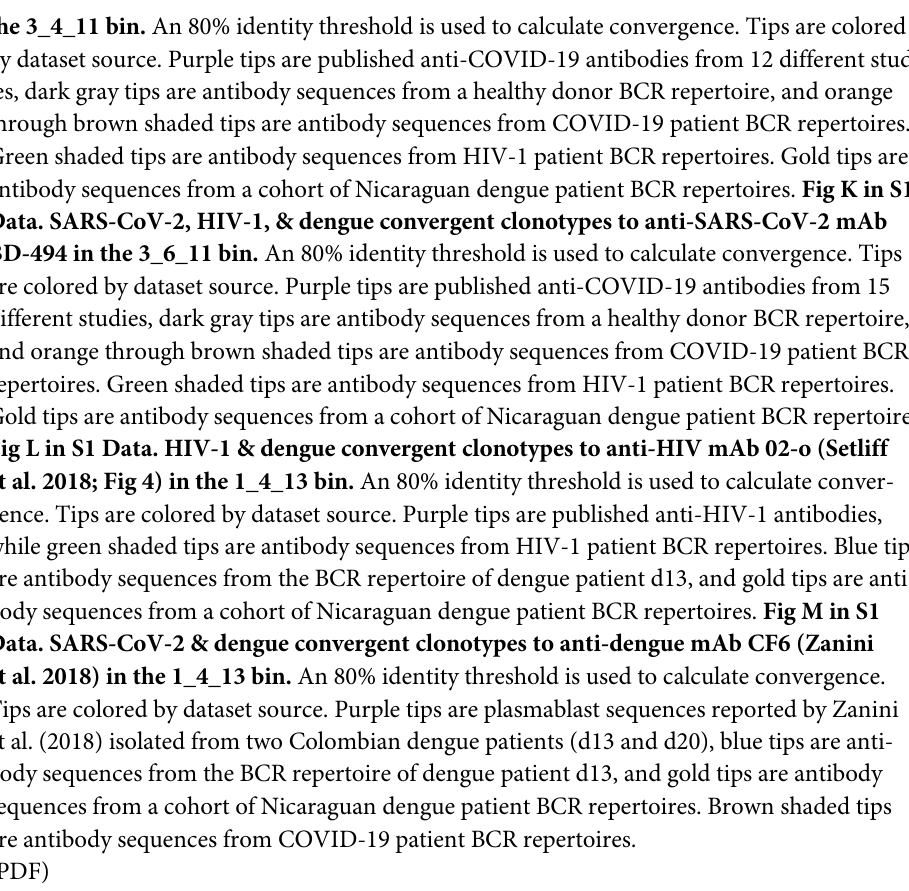
the 3_4_11 bin. An 80% identity threshold is used to calculate convergence. Tips are colored by dataset source. Purple tips are published anti-COVID-19 antibodies from 12 different stud- ies, dark gray tips are antibody sequences from a healthy donor BCR repertoire, and orange through brown shaded tips are antibody sequences from COVID-19 patient BCR repertoires. Green shaded tips are antibody sequences from HIV-1 patient BCR repertoires. Gold tips are antibody sequences from a cohort of Nicaraguan dengue patient BCR repertoires. Fig K in S1 Data. SARS-CoV-2, HIV-1, & dengue convergent clonotypes to anti-SARS-CoV-2 mAb BD-494 in the 3_6_11 bin. An 80% identity threshold is used to calculate convergence. Tips are colored by dataset source. Purple tips are published anti-COVID-19 antibodies from 15 different studies, dark gray tips are antibody sequences from a healthy donor BCR repertoire, and orange through brown shaded tips are antibody sequences from COVID-19 patient BCR repertoires. Green shaded tips are antibody sequences from HIV-1 patient BCR repertoires. Gold tips are antibody sequences from a cohort of Nicaraguan dengue patient BCR repertoires. Fig L in S1 Data. HIV-1 & dengue convergent clonotypes to anti-HIV mAb 02-o (Setliff et al. 2018; Fig 4) in the 1_4_13 bin. An 80% identity threshold is used to calculate conver- gence. Tips are colored by dataset source. Purple tips are published anti-HIV-1 antibodies, while green shaded tips are antibody sequences from HIV-1 patient BCR repertoires. Blue tips are antibody sequences from the BCR repertoire of dengue patient d13, and gold tips are anti- body sequences from a cohort of Nicaraguan dengue patient BCR repertoires. Fig M in S1 Data. SARS-CoV-2 & dengue convergent clonotypes to anti-dengue mAb CF6 (Zanini et al. 2018) in the 1_4_13 bin. An 80% identity threshold is used to calculate convergence. Tips are colored by dataset source. Purple tips are plasmablast sequences reported by Zanini et al. (2018) isolated from two Colombian dengue patients (d13 and d20), blue tips are anti- body sequences from the BCR repertoire of dengue patient d13, and gold tips are antibody sequences from a cohort of Nicaraguan dengue patient BCR repertoires. Brown shaded tips are antibody sequences from COVID-19 patient BCR